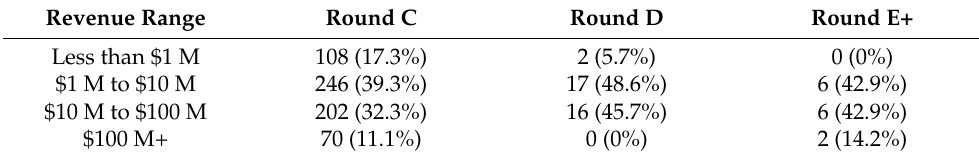
Table 5. Number of Startups by the Latest Reported Funding Round and Revenue Range. Revenue Range